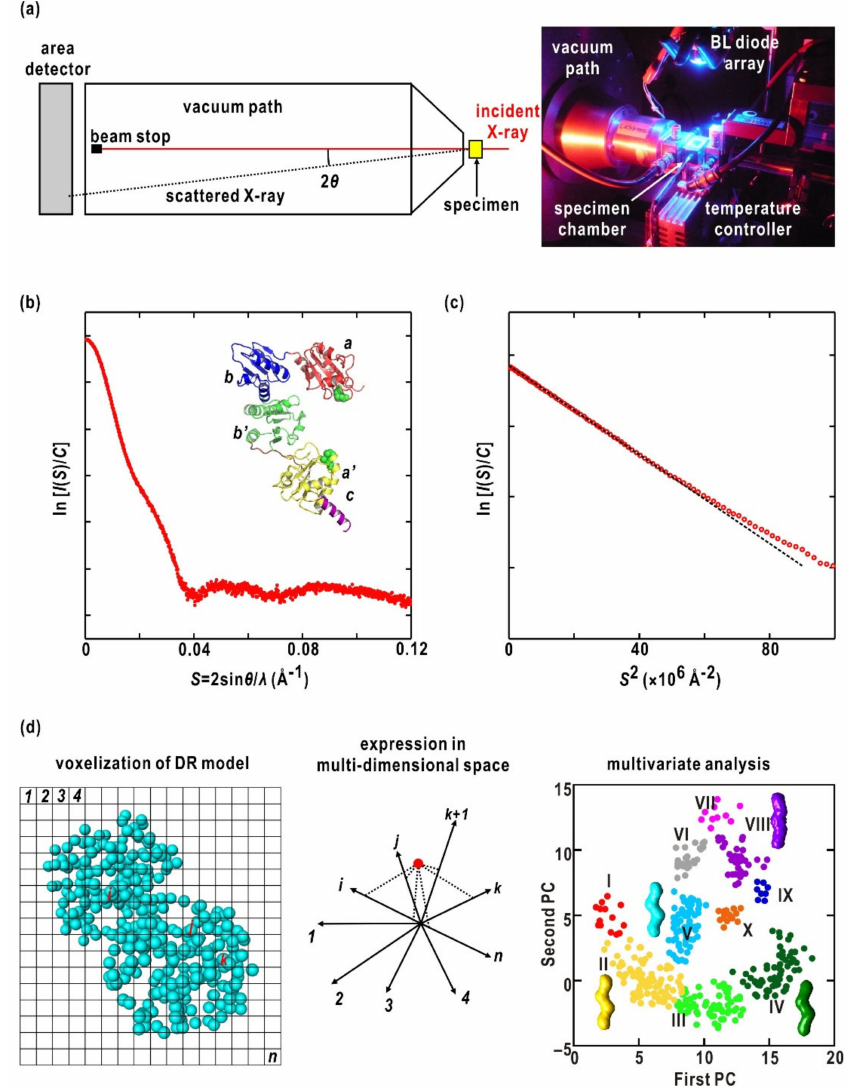
Figure 2. ( a ) A schematic illustration of the SAXS experiment (left) and a photograph of the specimen chamber (right). In the right photograph, the phot2 specimen was photo-excited by BL irradiation of a photo-diode. ( b ) SAXS profile of protein disulfide isomerase (PDI) from a thermophilic fungus [44]. A model of PDI is shown in the inset. The enhancements at approximately S = 0.03 Å − 1 are caused by the characteristic arrangement of the four domains in PDI. ( c ) A Guinier plot for the small-angle region in the SAXS profile in panel ( b ). The dashed regression line indicates R g of 33.4 ± 0.4 Å. ( d ) Schematic illustration of the multivariate analysis of models restored by ab initio calculation by the GASBOR program [45]. The details are described in the Materials and Methods